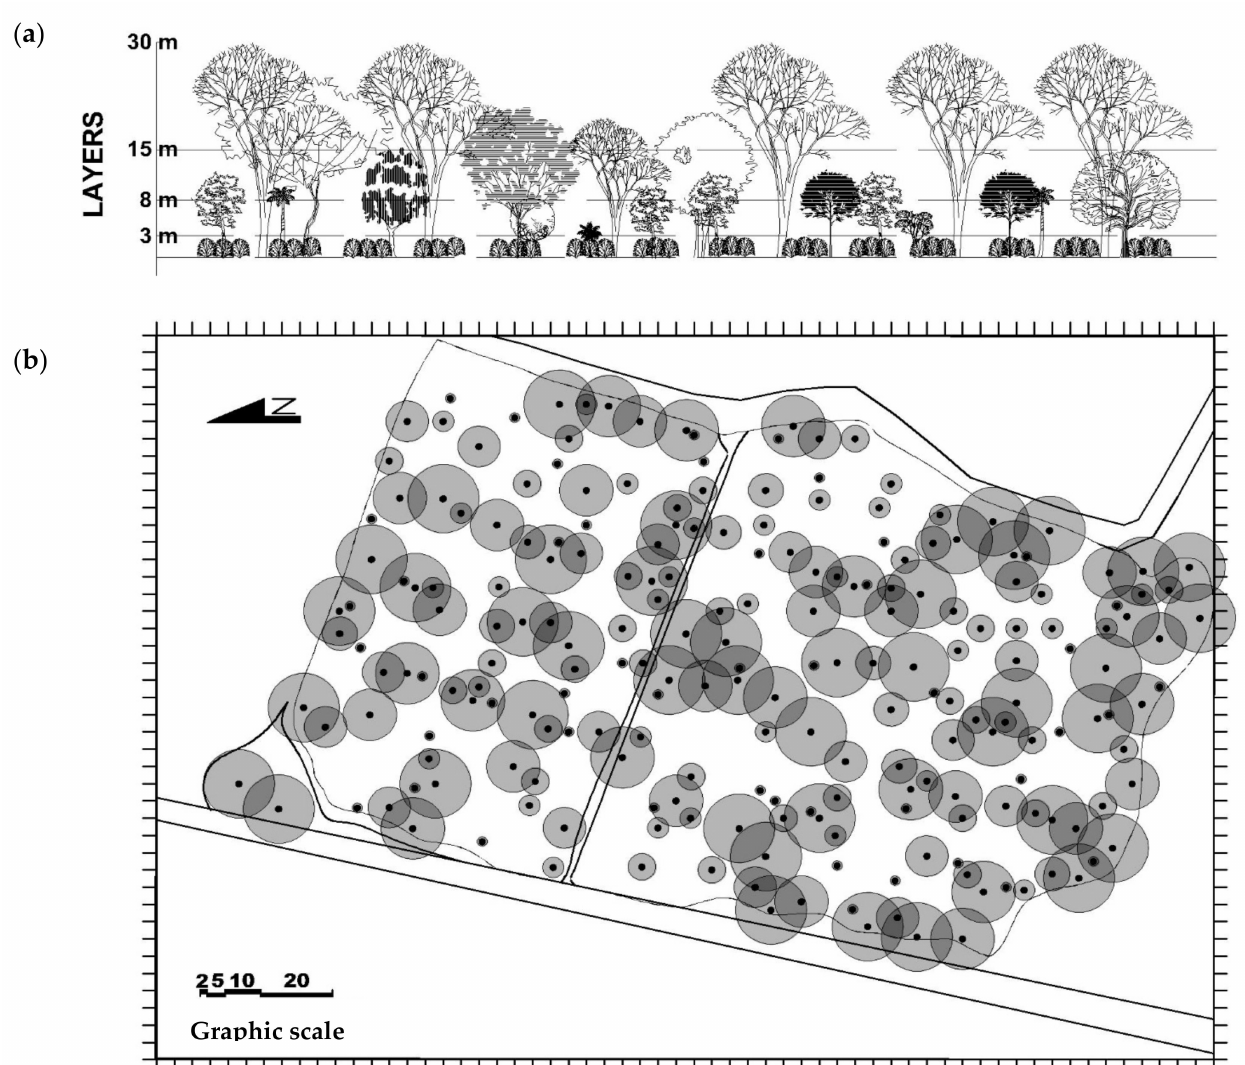
Figure 11. Arborization plan for a shaded coffee field employing diverse native shade trees, planted to imitate the local forest structure. ( a ) Layer 1, showing the soil surface to 3 m aboveground, is composed of coffee shrubs and short-stature plants, such as ground covers (e.g., Brachiaria) and insect-friendly species. Layers 2 and 3 (3–8 m and 8–15 m) are made up of low-stature trees and shrubs. Layer 4 corresponds to large-stature emergent canopy trees, which constitute the permanent backbone of the agroforestry system. ( b ) General view of the arborized plot. Circle sizes represent the expected shade